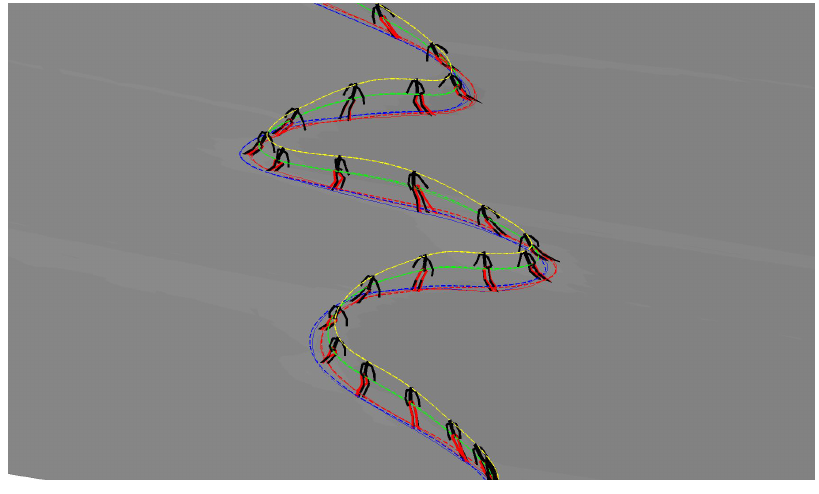
Figure 12. A comparison between the LWPR model (red) and measured pose (black). Note that the upper body pose was not estimated with the LWPR model.